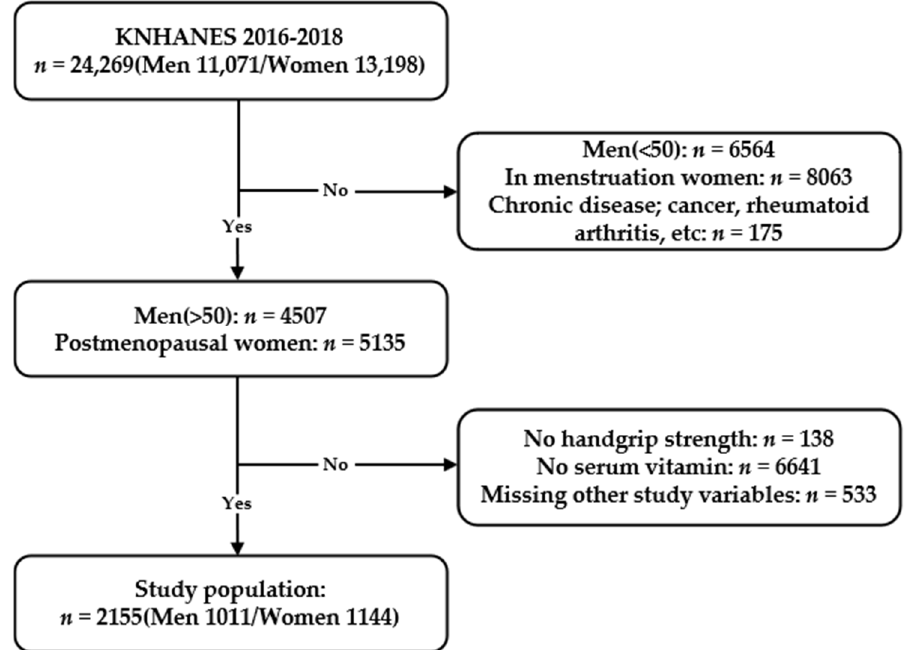
Figure 1. Flowchart of the study population from the Korean National Health and Nutrition Examination Survey Ⅶ (2016–2018) showing inclusions and exclusions.